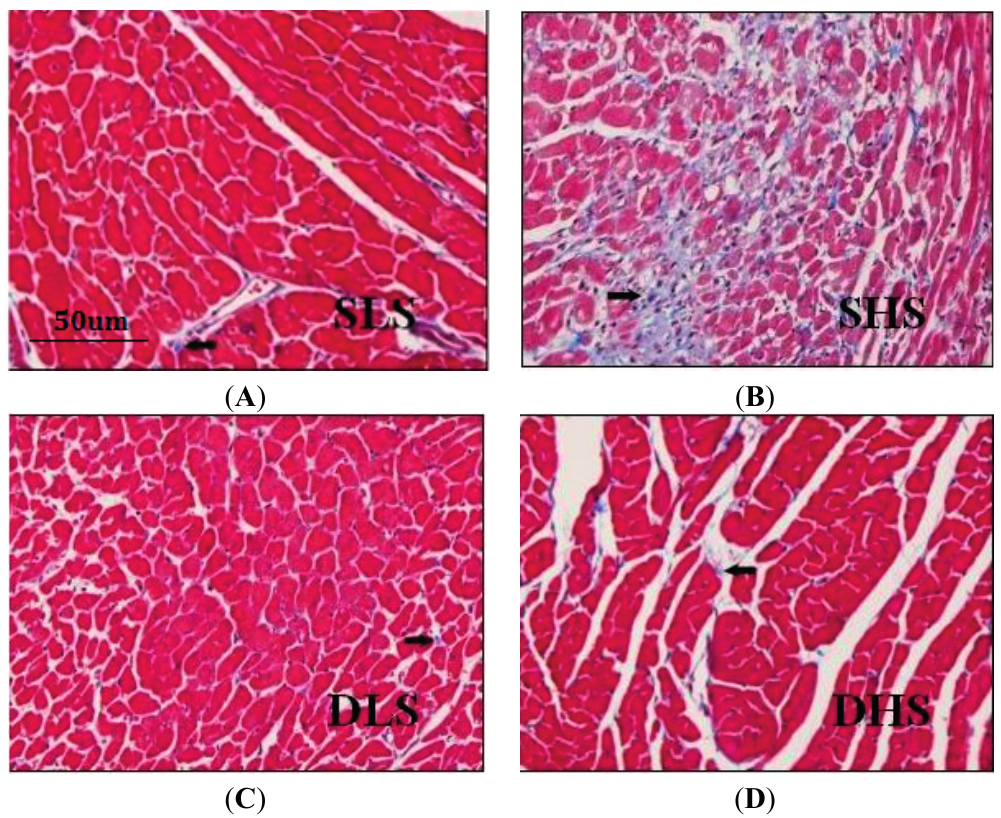
Figure 2. Micrographs of heart slices in the left ventricle of salt-sensitive (SS) rats and Sprague-Dawley (SD) rats. Masson’s staining was used for detection of collagen. The collagen I fibers are shown in blue. ( A ) Histologic slice of the left ventricle (LV) of SS rats received low-salt intake; ( B ) Histologic slice of the LV of SS rats received high-salt intake; ( C ) Histologic slice of the LV of SD rats that received low-salt intake; ( D ) Histologic slice of the LV of SD rats received high-salt intake. Arrows: the positive signal of collagen I fibers in myocardium.